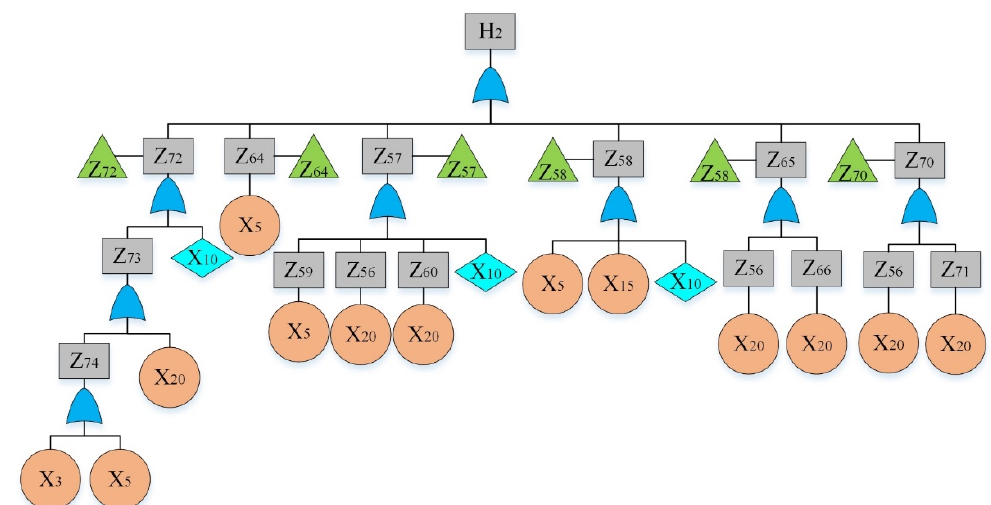
Figure 3. Fault tree of a hydraulic system: sub-tree I.